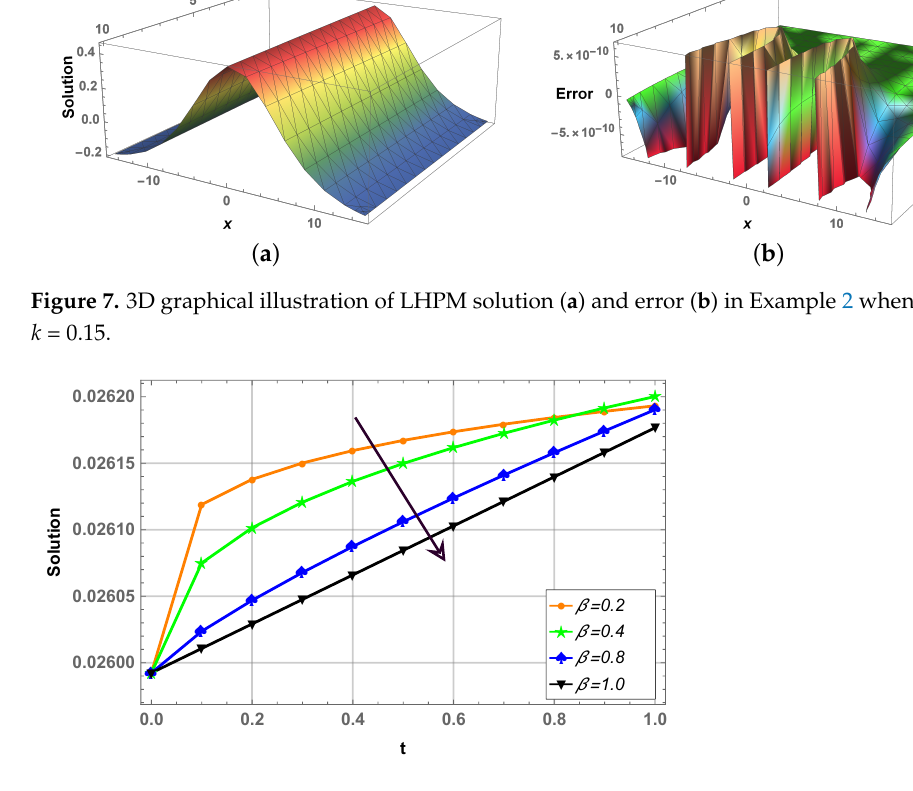
Figure 8. Effect of fractional parameter β on a time-fractional Ito equation (Example 2) when k = 0.1 and x = 10.